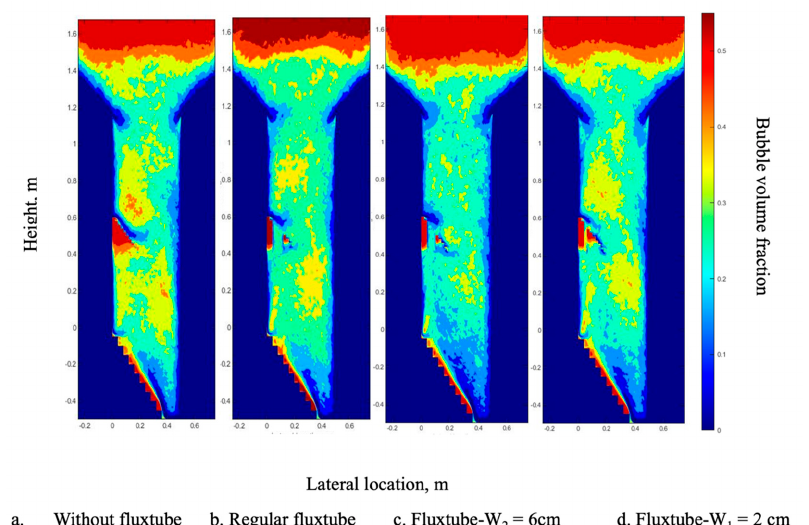
Figure 16. Bubble volume fraction contours at the baffle zone (0.40 m < y < 0.70 m) using the asymmetrical baffle without a fluxtube and with fluxtubes of different widths under the superficial gas velocity of 0.4 m/s for the even gas inlet con ‐ figuration.